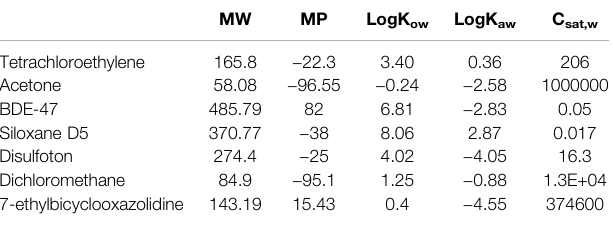
TABLE 2 | Chemicals used for illustrative model applications and their properties. MW MP LogK